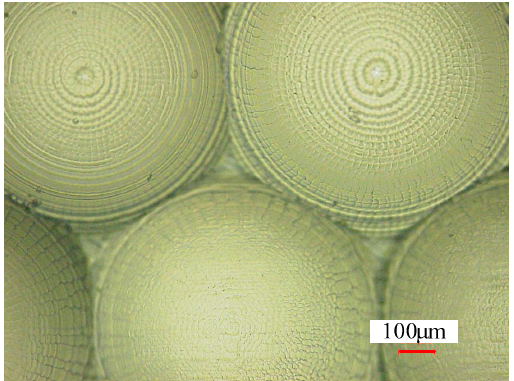
Figure 12. Surface morphology of the micro-lens array under different hot embossing parameters.